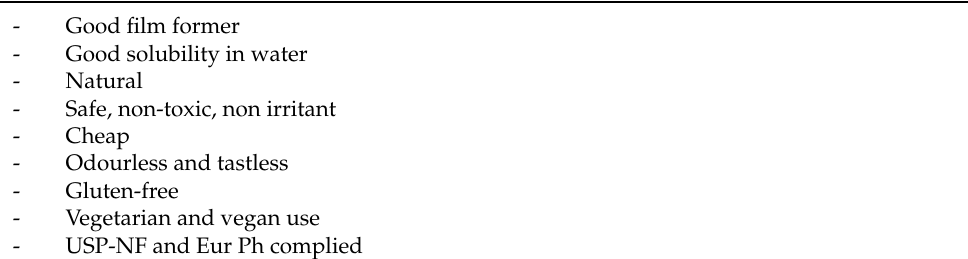
Table 3. Main characteristics of